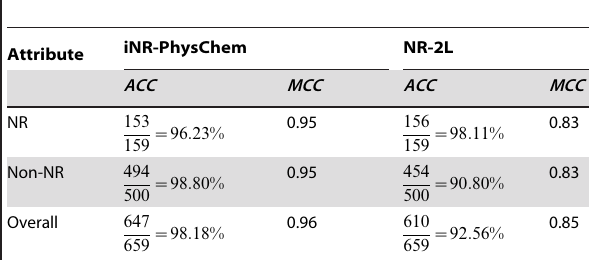
Table 3. Comparison of the success rates and MCC values obtained by the current iNR-PhysChem and NR-2L [16] in identifying NRs and non-NRs by the jackknife test on the benchmark dataset S (cf. Eq. 1